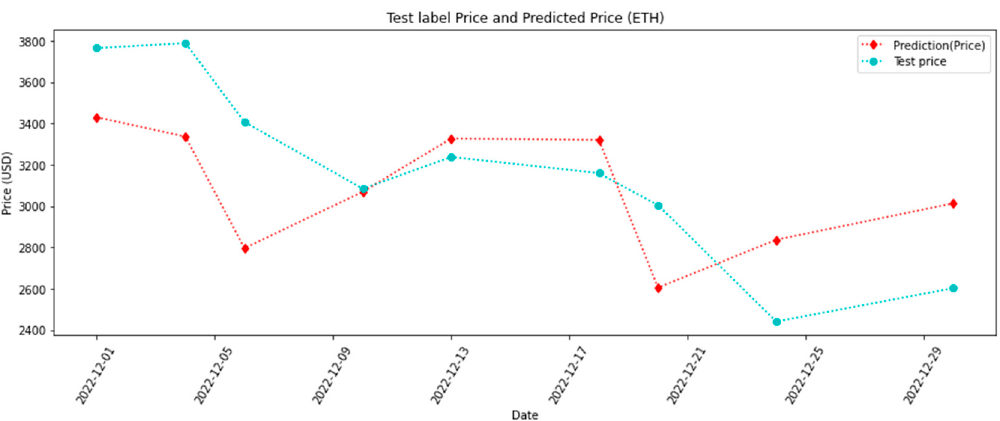
Figure 16. The plot of tested vs. predicted trend in Dogecoin.